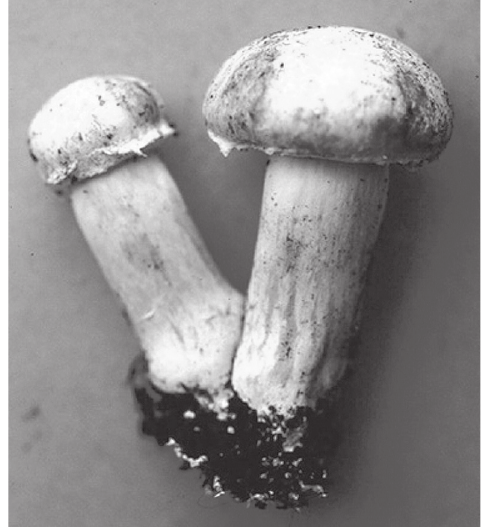
Fig. 1. Superficial brown discolorations on both caps and stalks of Agaricus bisporus